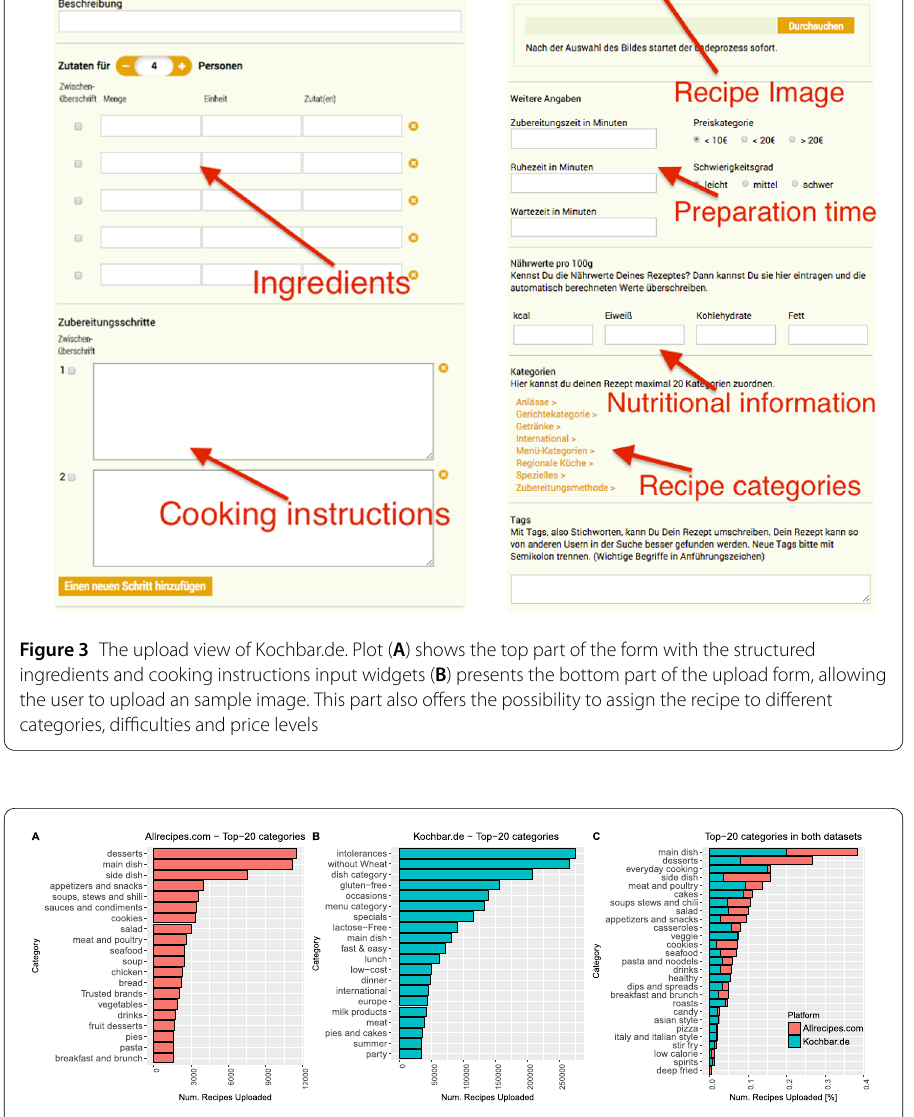
Since both datasets had been used for other purposes in the context of previous stud- ies [41, 64], the data had already been structured and partially cleaned. That being